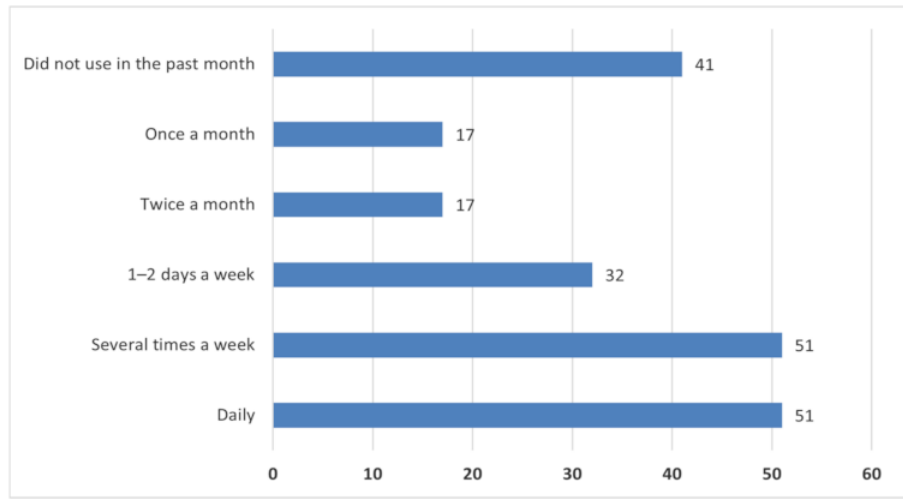
Figure 3. Health app usage